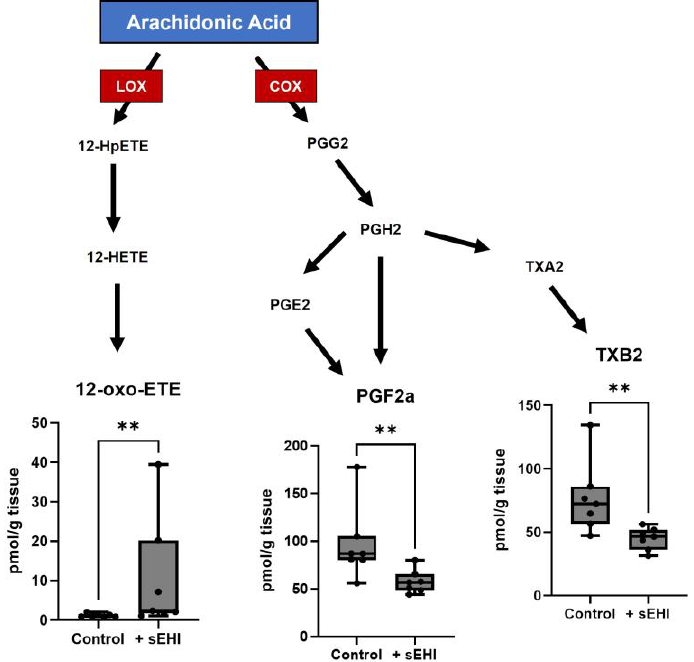
Figure 5. Oxylipins altered by sEHI in females. Boxplots of oxylipins that were significantly different in the brains of sEHI-treated and control female mice are shown in a diagram demonstrating the pathways producing the oxylipins from arachidonic acid. The box extends from the 25th to the 75th percentile, with the middle line indicating the median. The whiskers extend to the minimum and maximum values, with individual values indicated by black dots. For definitions of oxylipin abbreviations see Table S1. LOX: lipoxygenase enzyme; COX: cyclooxygenase enzyme; ** p < 0.01.